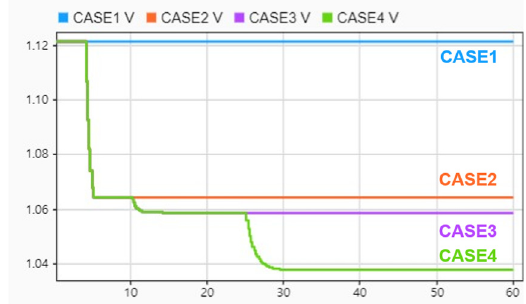
Figure 15. PCC voltage of the G1 inverter.